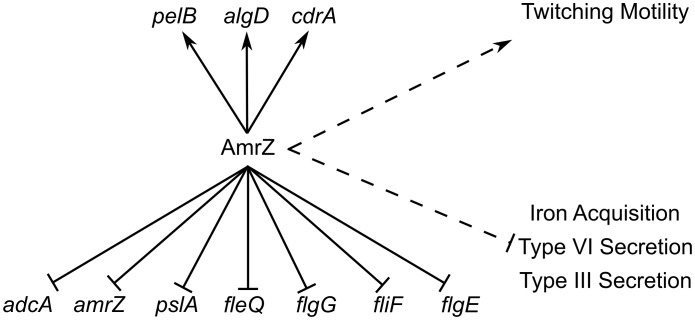
ChIP-Seq and RNA-Seq establish the AmrZ regulon.Direct (solid lines) and indirect (dashed lines) activity of AmrZ on various genes involved in virulence. Current work has expanded the understanding of the AmrZ regulon to include several new systems, including iron acquisition, type III secretion, type VI secretion, flagellum structure, Pel polysaccharide, and the biofilm structural protein CdrA.